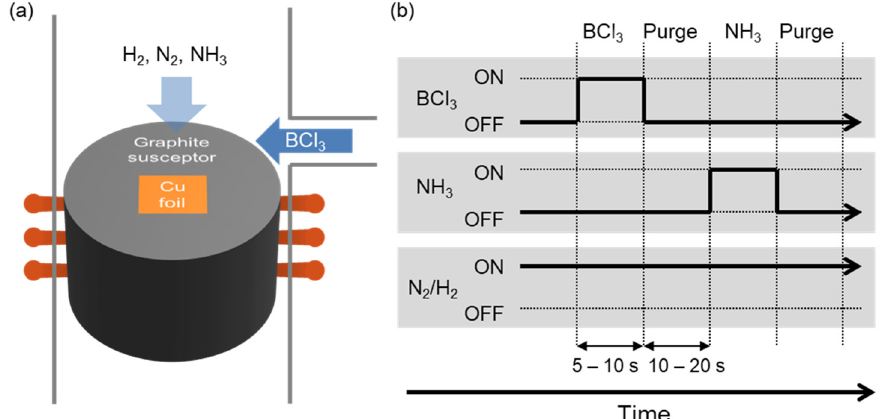
Figure 1. Synthesis of the h-BN layers using sequential-pulsed CVD process. ( a ) Schematic illustration of the cold-wall CVD system. ( b ) Diagram for the injection sequence of the gas precursors (BCl 3 and NH 3 ) and ambient gases (N 2 and H 2 ).